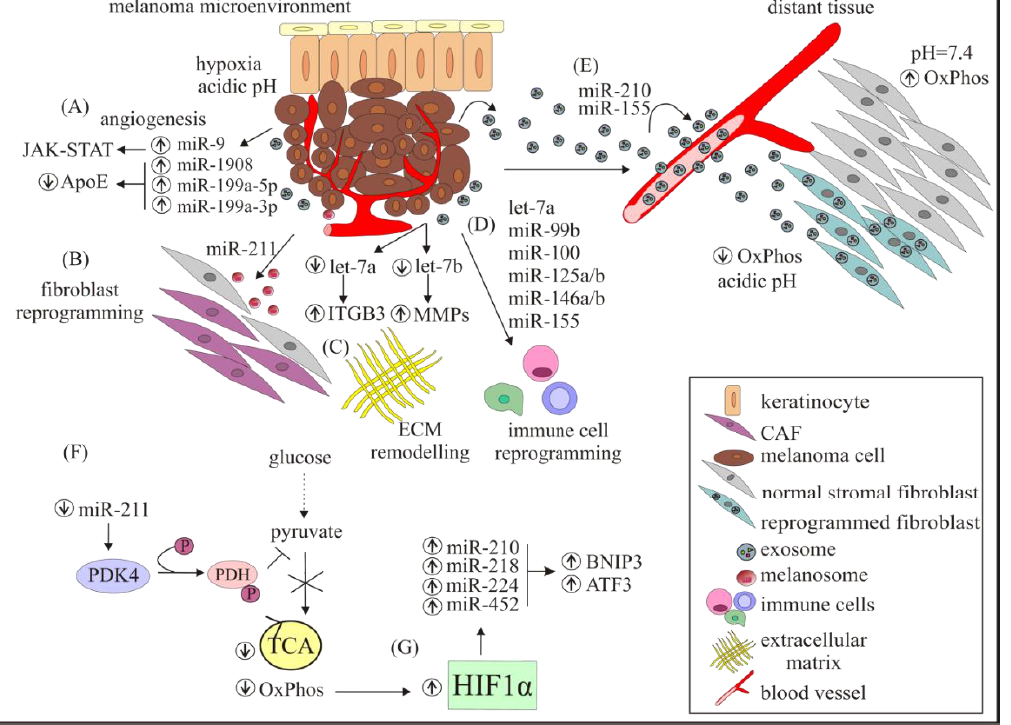
Figure 2. Characteristics of melanoma microenvironment modifications triggered by miRNAs, and the formation of a metastatic niche by melanoma-derived exosomes. The melanoma microenvironment is comprised of various types of cells, and modified by miRNAs that play an important role in: ( A ) angiogenesis; ( B ) transformation of normal fibroblasts toward CAFs (cancer-associated fibroblasts); ( C ) ECM remodeling; and ( D ) immune cell reprogramming. ( F ) Modulation of metabolic pathways. ( G ) HIF-1 α stabilized in hypoxic conditions increases the levels of several miRNAs. ( E ) Melanoma-derived exosomes containing miRNAs that contribute to reprogramming cells in distant tissues to prepare the pre-metastatic niche. AFT3: activating transcription factor 3; BNIP3: BCL2/adenovirus E1B interacting protein 3; ECM: extracellular matrix; HIF-1 α : hypoxia inducible factor 1 α ; OxPhos: oxidative phosphorylation; PDH: pyruvate dehydrogenase; PDK4: pyruvate dehydrogenase kinase 4; and TCA: tricarboxylic acid